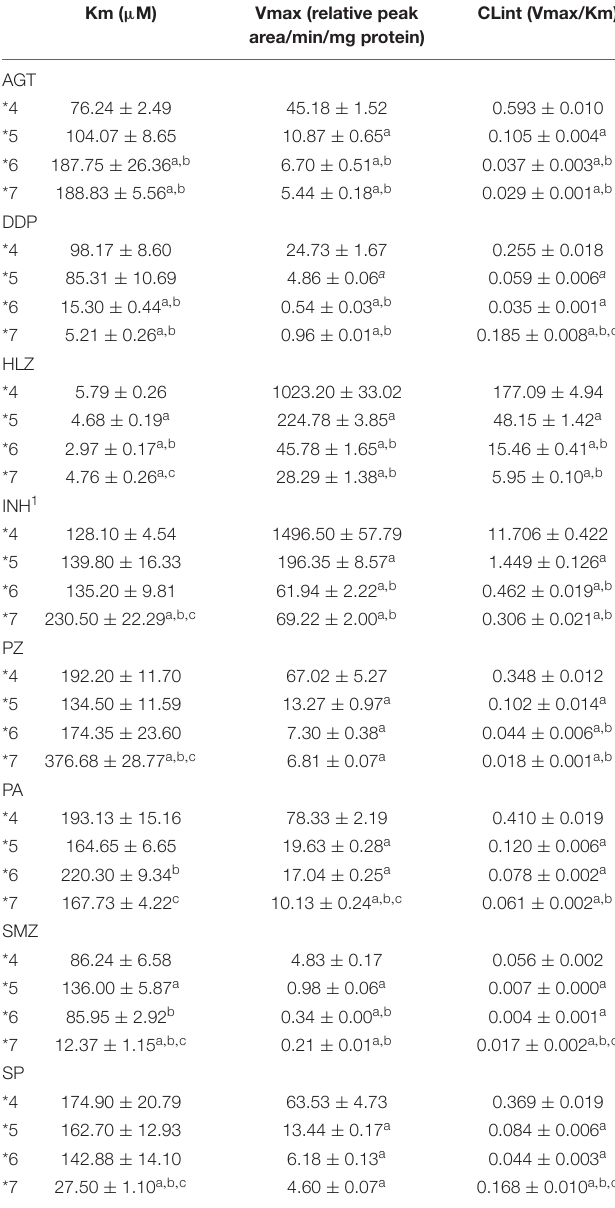
TABLE 2 | Enzyme kinetic parameters for the N -acetylation of eight drugs using recombinant proteins encoded by NAT2*4 , *5 , *6 , and *7 alleles. Km ( µ M) Vmax (relative peak area/min/mg